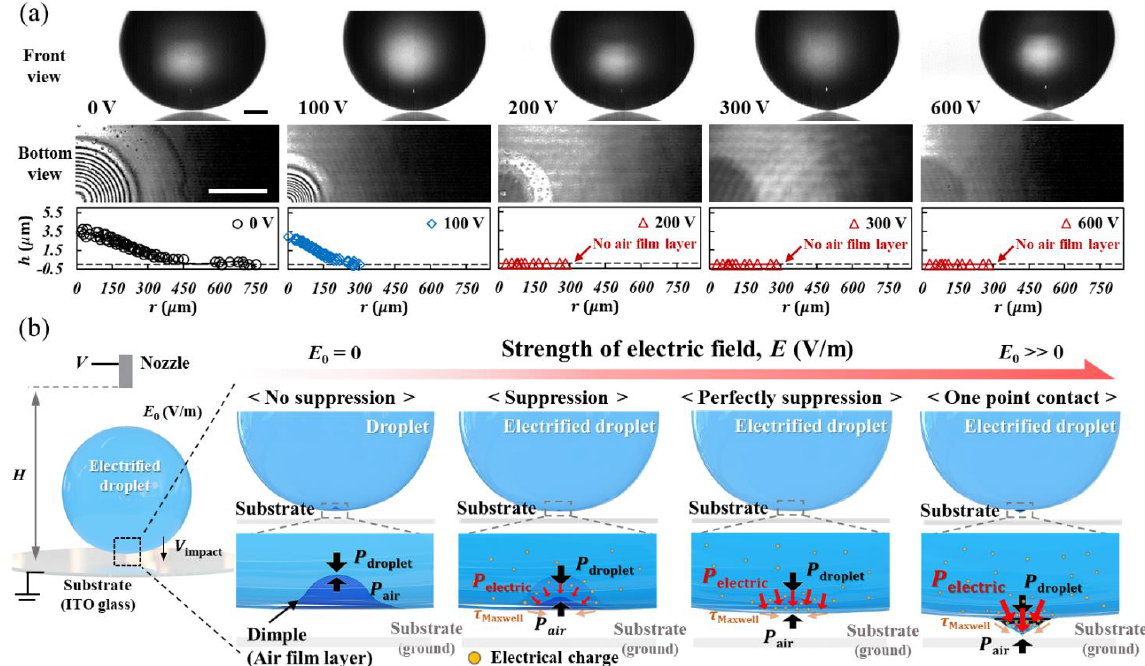
Figure 4. Coalescence dynamics of an electrified droplet under the electric field. ( a ) Front- and bottom-view of the electrified droplet at the colliding moment as the electric field strength increases under the fixed dripping height (5 mm). Scale bars: 300 µm. ( b ) Schematic illustration of the concept of electric pressure affecting to the suppression of dimple formation. The cone-shaped interfacial morphology was observed between two oppositely col- liding charged droplets in a quasi-static condition under an electric field by other research- ers [45,46]. However, the previous research studied the interfacial change of two oppo- sitely charged droplets due to the electric field in a dielectric medium, not an air film layer formation and its suppression. Here we report the interfacial morphologic change and the suppression of dimple by the electric field when the electrified droplet collides with the grounded substrate. To characterize cone- shaped interface’s deformation, we measured the contact cone angles ( β ) between the substrate and droplet while applying various voltages with the same dripping height. (Figure S4) The contact cone angle refers to the instant angle with the substrate when the droplet firstly contacts the substrate. The contact cone angle, which had shown 11° in 300 V, increased to 30° in 1300 V. It clearly demonstrated that the contact cone angle increased proportionally to the magnitude of the applied voltage (the strength of the electric field) (Figures S4 and S5c), which is similar to the reference [47]. It means that the droplet’s morphological change under the electric field is caused by electric forces (stress) due to the electrical charge and the electric field. The droplet’s diameter and ve- locity that has changed due to the electric field and electric force might have affected air film suppression in the experiment. We measured the droplet diameters and impact ve- locities according to the different applied voltages to ensure consistent experimental con- ditions. There were no considerable changes in droplet diameter and impact velocities even under 0 to 300 V, the range that we clearly observed the effect of the electric field on the suppression. (Figure S5b) It means that the suppression of dimple is not caused by the increase of inertia force (velocity) and the change of surface tension force (droplet diame- ter) on the droplet. We wanted to evaluate only the electric force’s effect on the dimple formation without the change of the inertia (diameter, impact velocity) or change of sur- face tension on the droplet. Therefore, we could explain the mechanism of the suppression of the air film and the cone-shaped deformation by the effect of electric forces, utilizing the voltage range in 0 – 300 V.